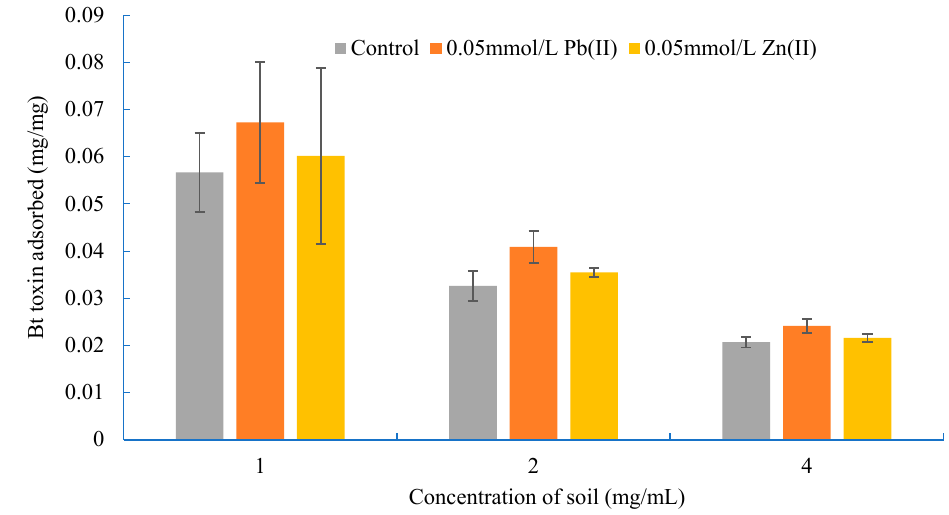
Figure 2. Effects of lead and zinc ions on Bt toxin adsorption under different soil concentrations.